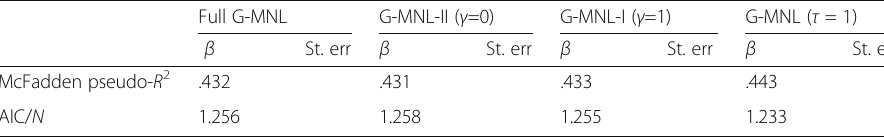
Table 6 Heterogeneity in mean taste parameter models